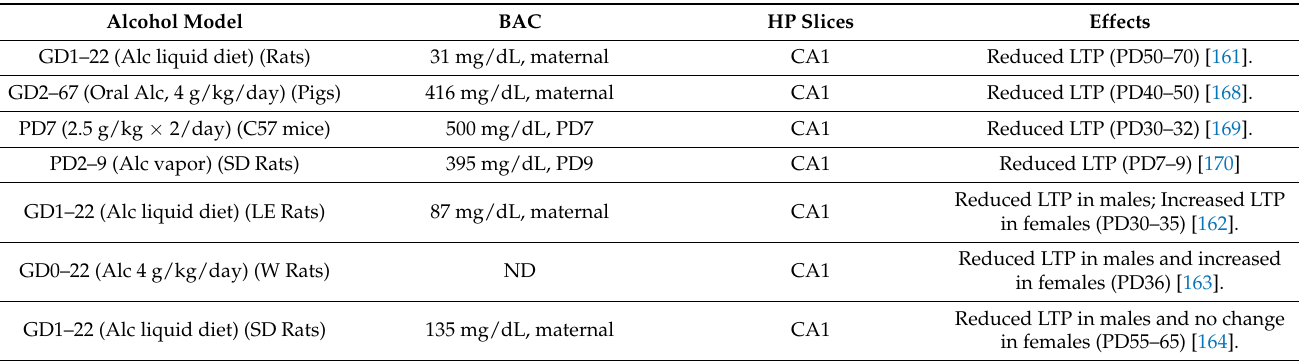
Table 3. Summary of developmental alcohol exposure effects on hippocampal LTP and LTD in